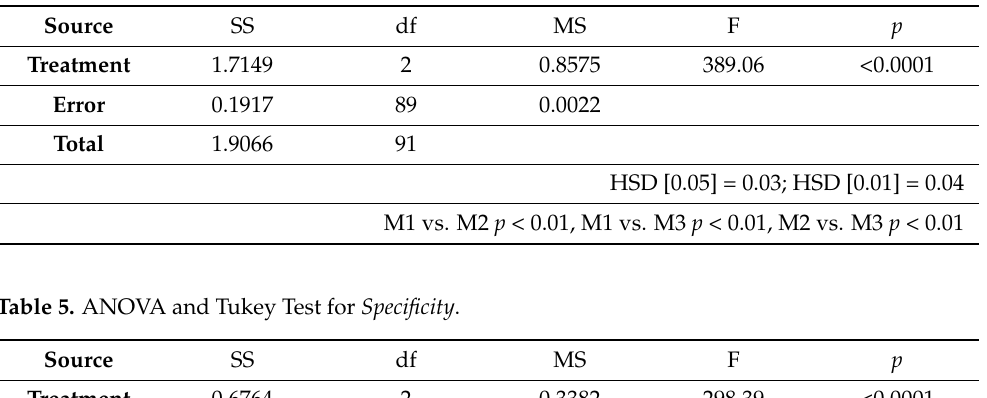
Table 4. ANOVA and Tukey Test for Sensitivity .